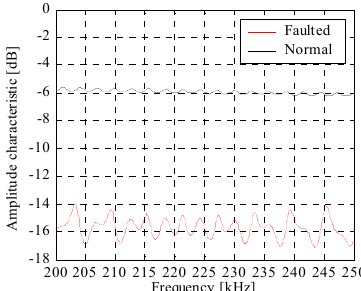
Figure 10. Amplitude characteristics of the faulted power line. The middle phase to ground coupling. The broken middle phase 25 km away from the sending end, with the middle phase conductor open-circuited at the left side and short-circuited at the right side at the fault location.